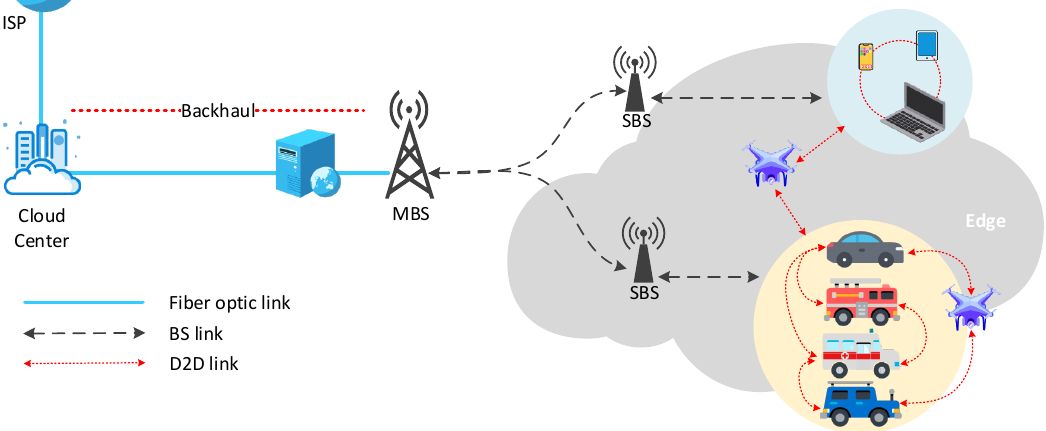
Figure 1. Architecture of